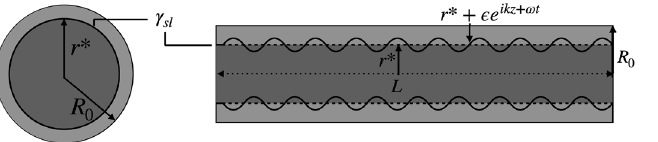
Figure 2. A surface melted nanowire of radius R 0 and length L . The solid core radius during solid-liquid phase coexistence is r ∗ . This surface has undergone a small perturbation in the form of a plane wave r ∗ + ε e ikz + ω t . γ sl represents the solid-liquid interfacial